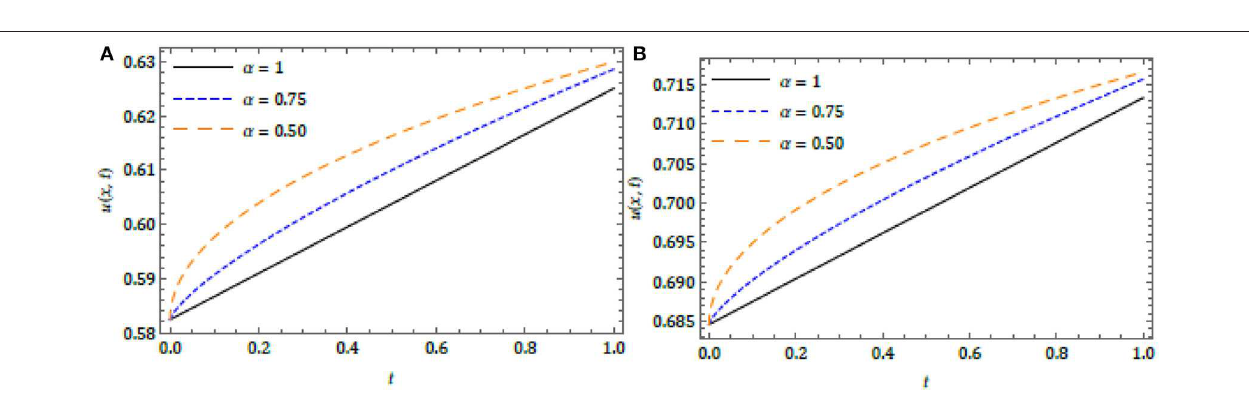
Frontiers in Physics |